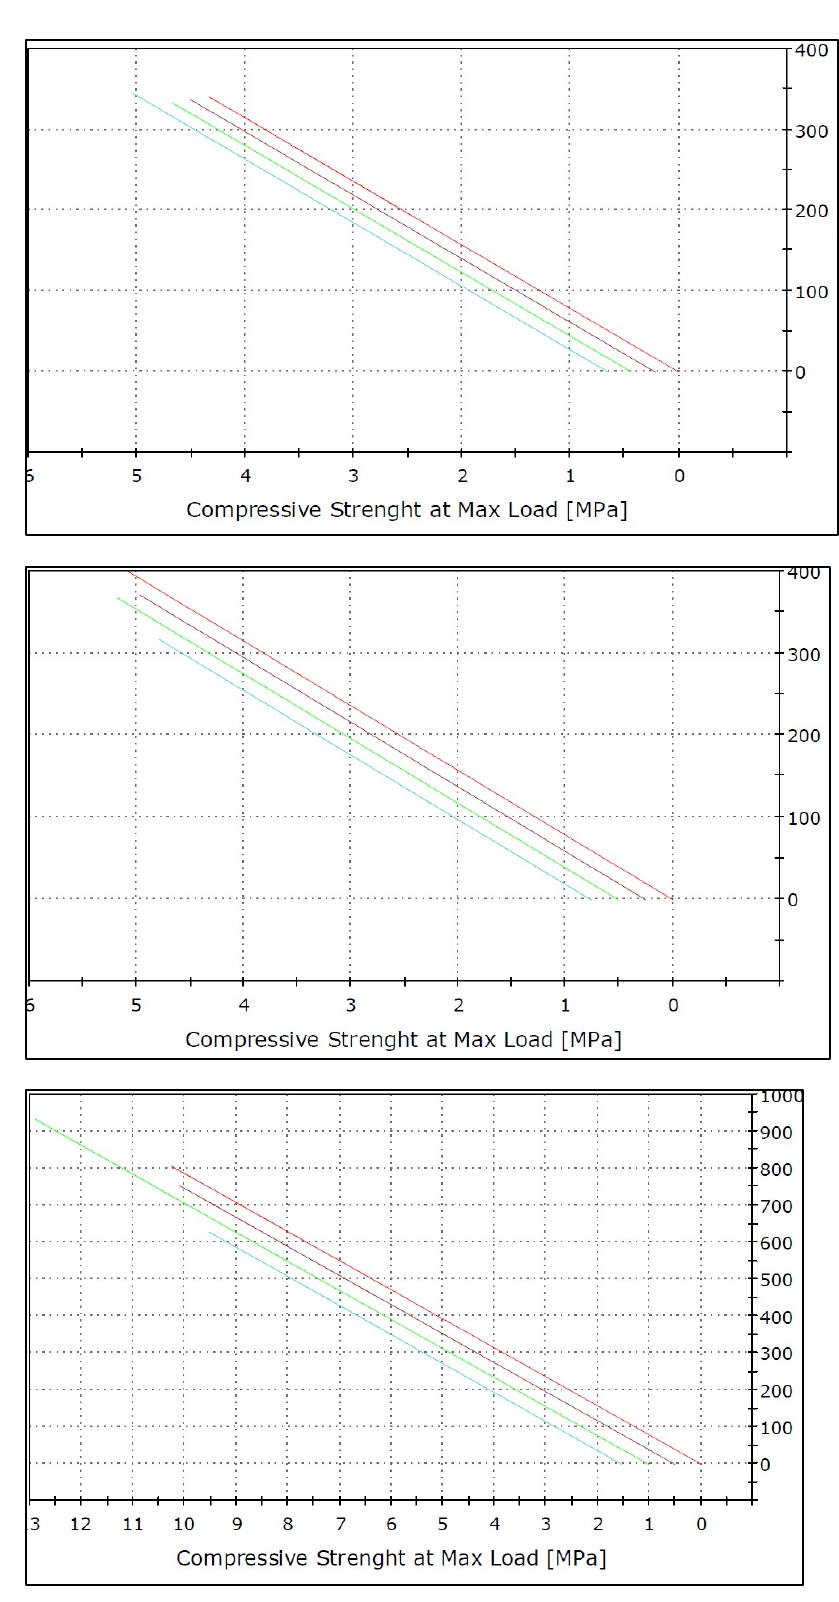
Figure 5 Figure 4. Mean biaxial fracture force resistance amongst different ceramic